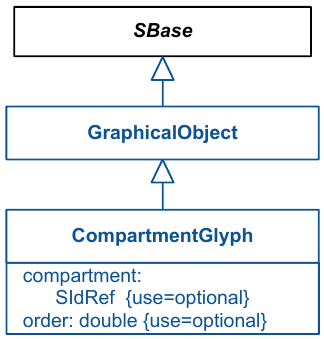
Figure 10: The definitions of the CompartmentGlyph